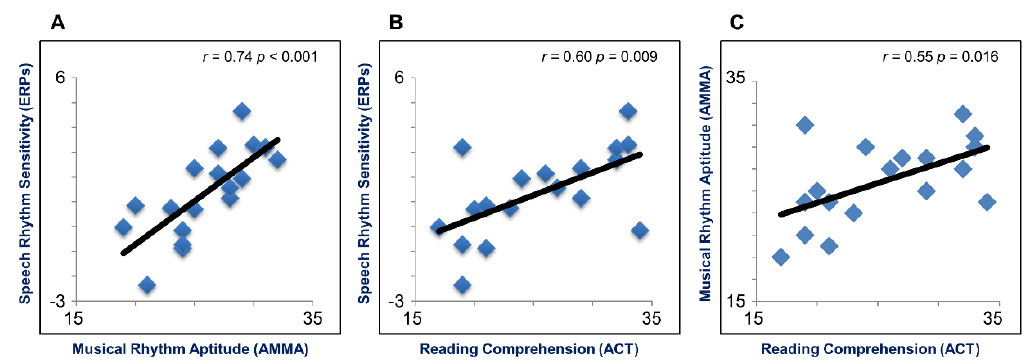
Figure 3. Brain-behavior correlations. ( A ) Correlation between speech rhythm sensitivity (as indexed by the negative ERP cluster mean difference) and musical rhythm aptitude; ( B ) correlation between speech rhythm sensitivity and reading comprehension; ( C ) correlation between musical rhythm aptitude and reading comprehension. (Note: The solid line represents a linear fit.)